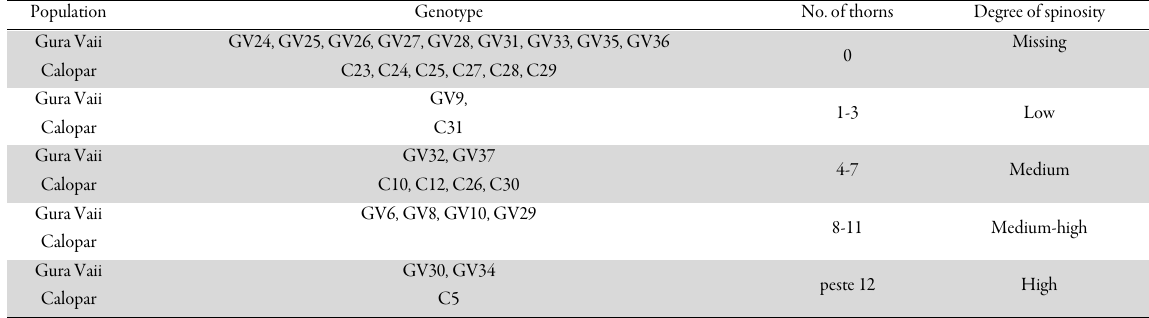
Table 5. Degree of spinosity in Prunus spinosa L. genotypes in southern area of